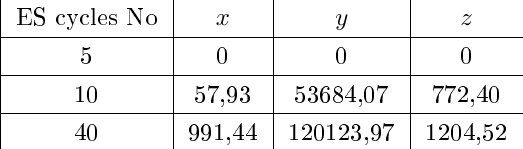
Tab. 1: Experiment variability depending on number of ES cycles for variables x,y and